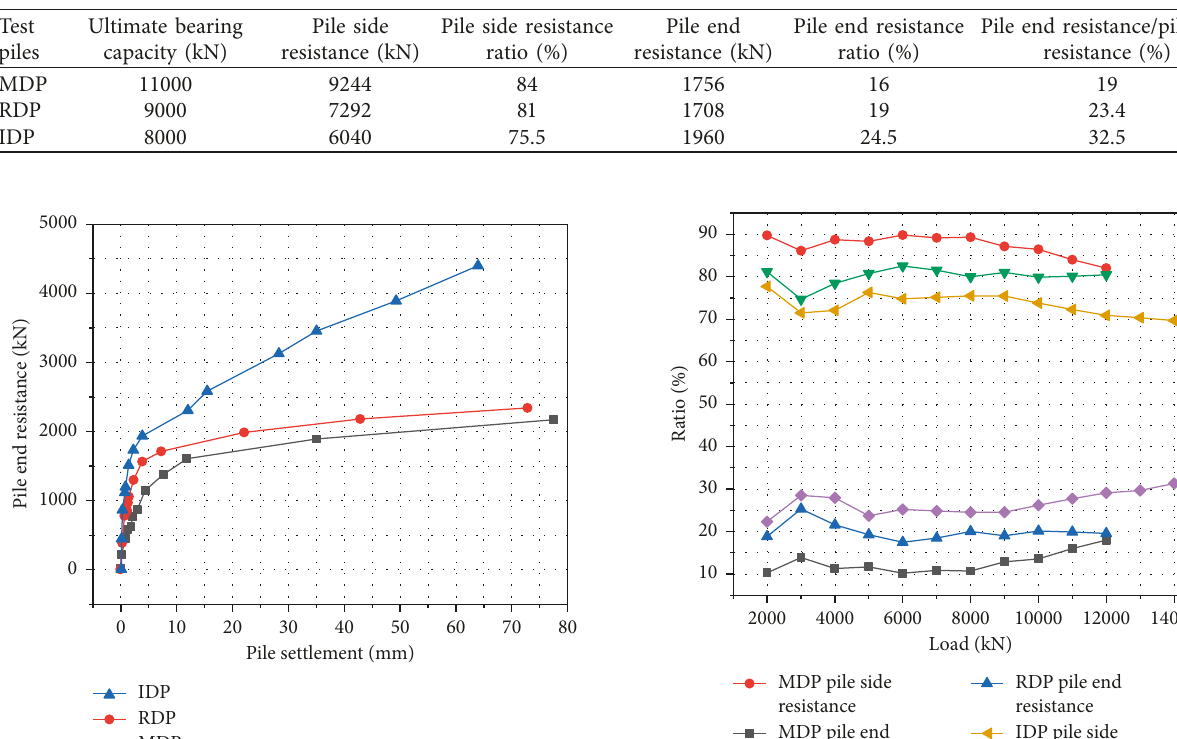
Table 4: Pile side and pile end resistance of test piles in ultimate bearing state.